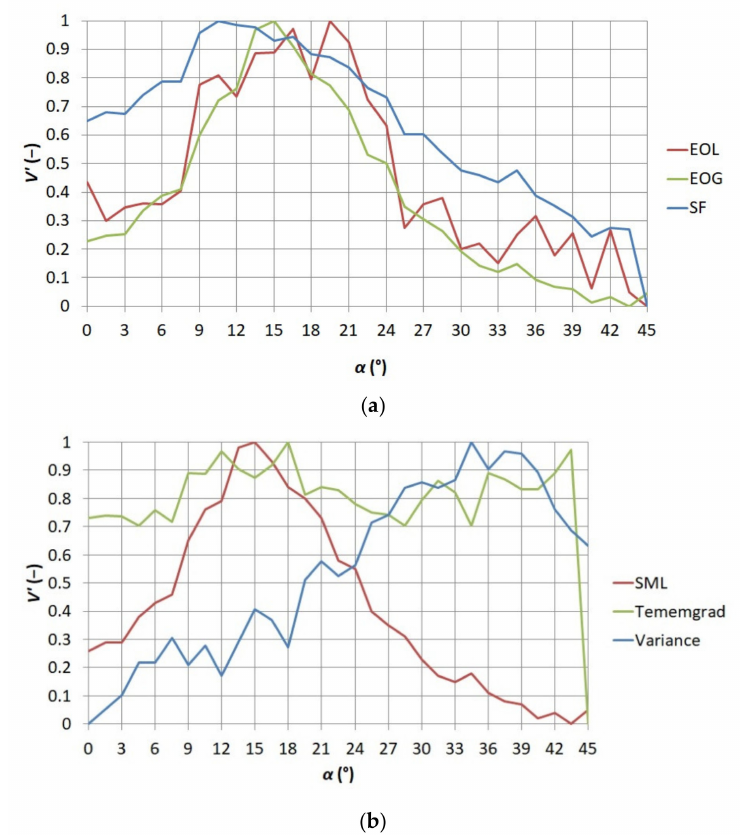
Figure 5. Relationship between the standardized value of sharpness measures V (cid:48) and the angle of focusing ring mounted on the thermographic camera lens α for the first series of thermograms ( a ) EOL, EOG, and SF ( b ) SML, Tenengrad, and